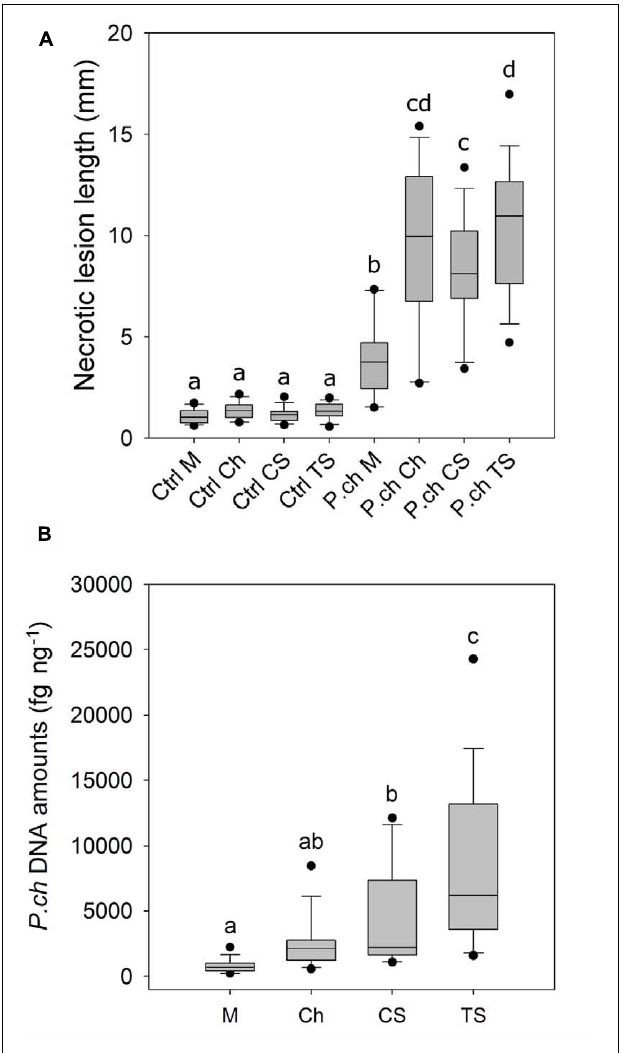
FIGURE 1 | Level of susceptibility of Vitis vinifera cultivars to P. chlamydospora ( P. ch ) as expressed by wood necrotic lesion length and fungal DNA amounts in in planta bioassays. (A) Wood necrotic lesion length that developed above the inoculation point. (B) Amount of P. chlamydospora DNA in xylem tissue fragments above and distant from the inoculation point (L2; 15–30 mm). Pooled data from 2013 and 2014 trials are shown. Different letters indicate statistically significant difference ( P < 0.05). Detailed outputs of the statistical analyses of data are provided in Table 1 and Supplementary Tables 2, 3. M, Merlot; Ch, Chardonnay; CS, Cabernet Sauvignon; TS, Thompson Seedless.